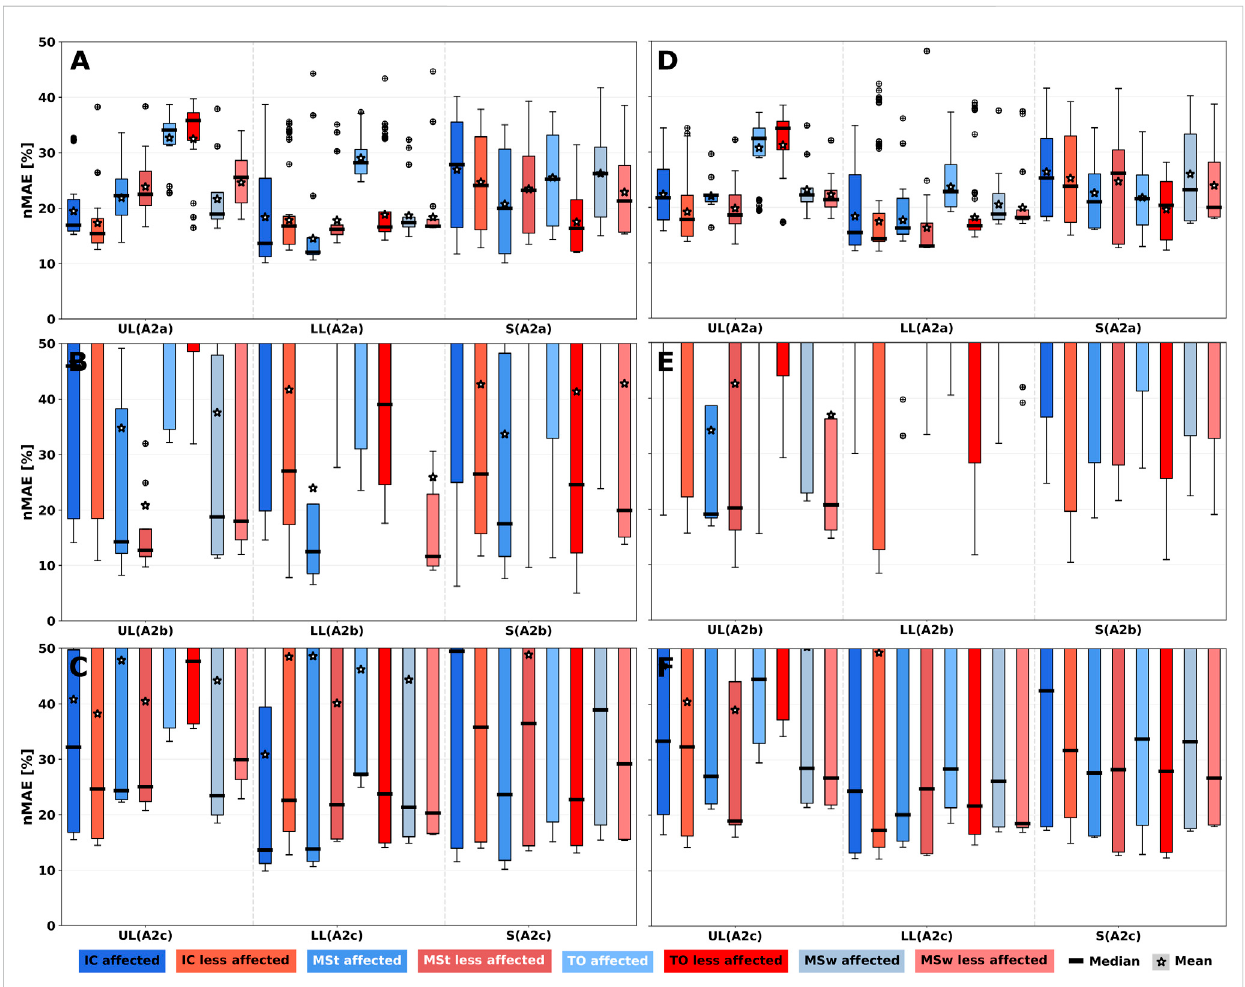
FIGURE 8 4-phase gait event nMAE of all simulated sensor positions summarised per body segment for Algo. A2 variants. nMAE axes were limited to highlight practically relevant sensor performances with nMAE below 50%. For full-range diagrams, please see Supplementary Figure S7. Gait events are Initial Contact (IC), Mid Stance (MSt), Toe off (TO) and Mid Swing (MSw). (A – C) PRE intervention. (D – F) POST intervention. (A,D) User-dependent and sensor position-dependent parameterisation (A2a). (B,E) User-independent parameterisation. (C,F) User-dependent and sensor position-independent parameterisation. UL: Upper leg, LL: Lower leg, S: